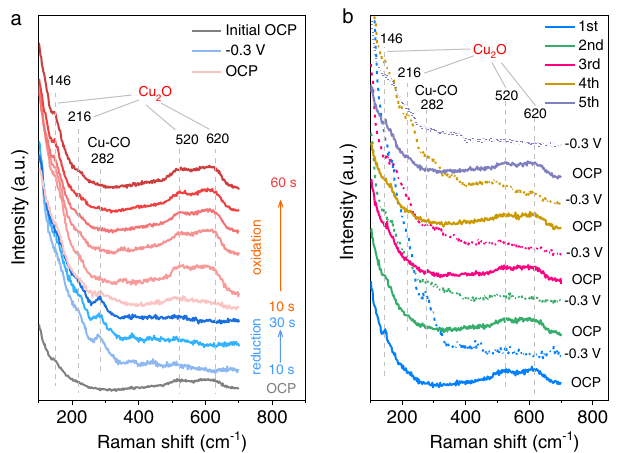
Fig. 1 In situ Raman spectra of OD-Cu electrodes in CO 2 -saturated 0.5M KHCO 3 . a Real-time Raman spectra of surface Cu 2 O species at − 0.3 V RHE and subsequently at open circuit potential (OCP). b Raman spectra under loop tests with a reduction potential at − 0.3 V RHE for 10 s and reoxidation potential at OCP for 20